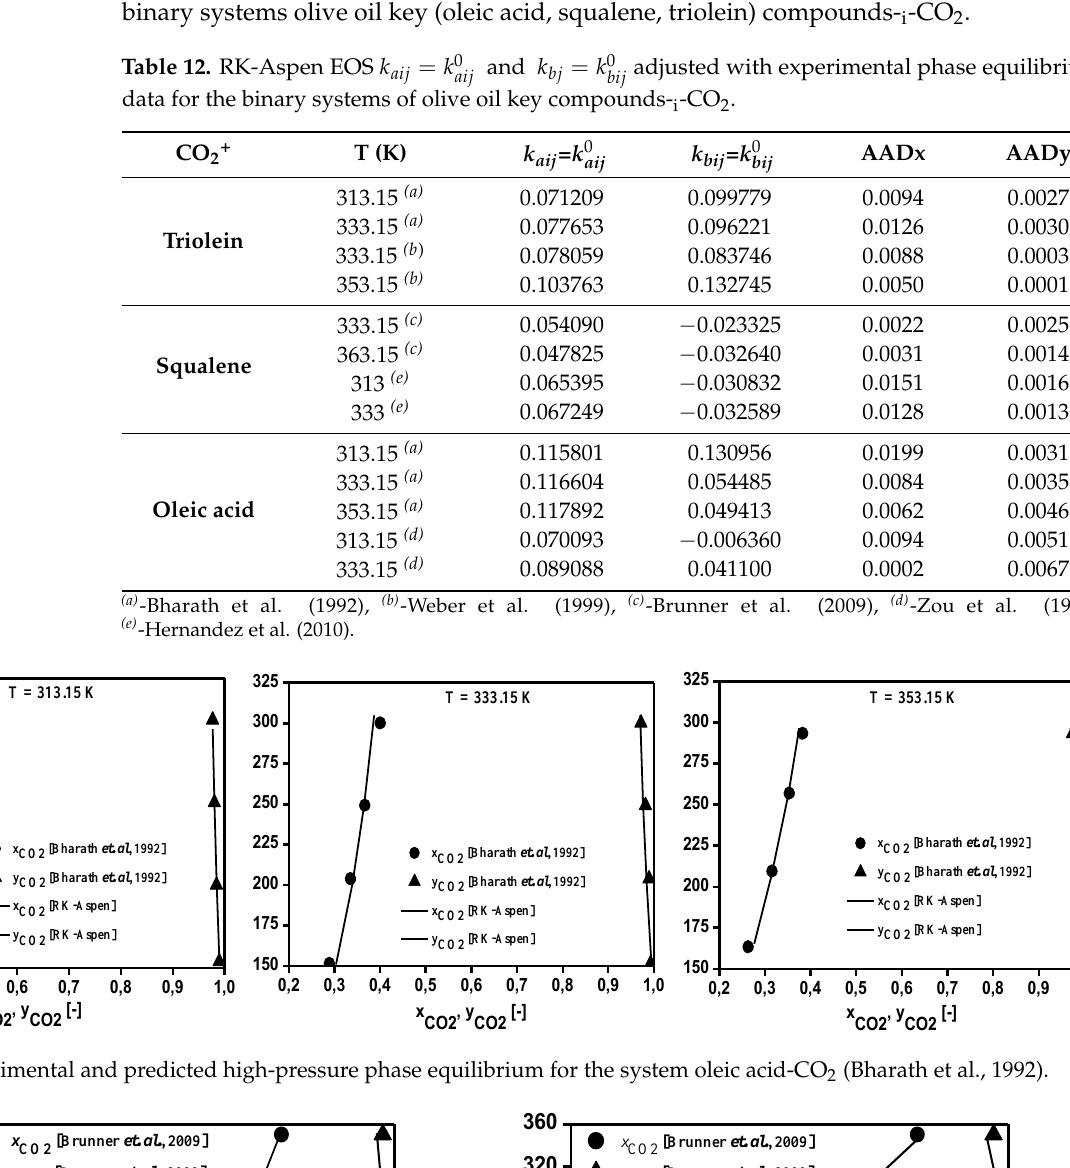
T = 353K Figure 4. Experimental and predicted high-pressure phase equilibrium for the system triolein-CO 2 (Weber et al., 1999). Simulation Modeling for the Model System Olive Oil Key (Oleic Acid-Squalene-triolen- CO 2 Because high-pressure phase equilibrium data for the complex system OLP-CO 2 is not available in the literature, the proposed methodology tested to simulate the thermodynamic modeling by de-acidification of olive oil, represented by a quaternary model mixture oleic acid-squalene-triolein-CO 2 . Table 13 presents the RK-Aspen EOS temperature independent binary interaction parameters adjusted to the experimental high-pressure equilibrium data for the multicomponent olive oil-CO 2 , described in Table 14 [90], and represented in this work as a multicomponent model mixture oleic acid-squalene-triolein-CO 2 . In addition, Table 13 presents the root-mean-square deviation (RMSD) between the multicomponent experimental high-pressure equilibrium data and the computed results for the coexisting gaseous-liquid phases. Table 13. RK-Aspen EOS temperature-independent binary interaction parameters adjusted with experimental high- pressure phase equilibrium data for the model systems oleic acid(1)-squalene(3)-triolein(2)-CO 2 (4). 𝒌 𝒊𝒋